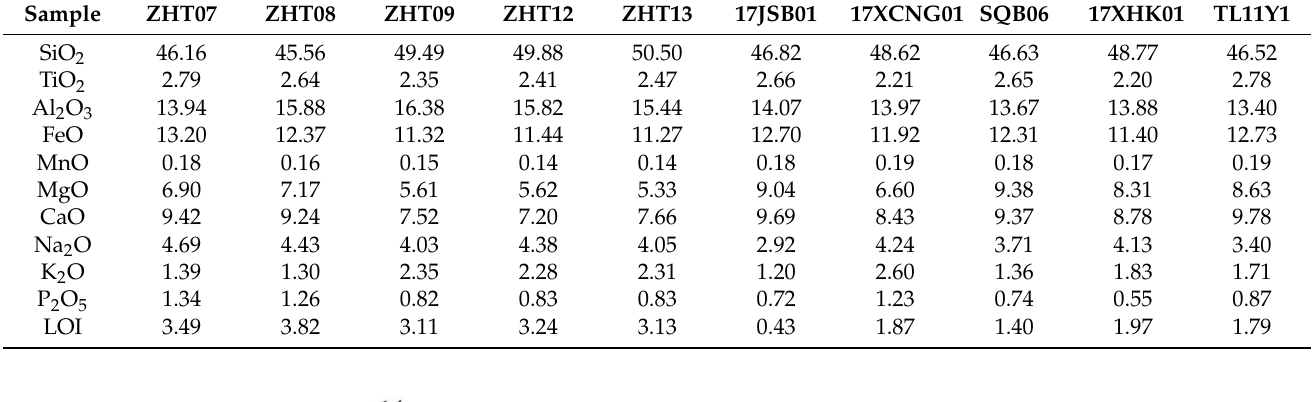
Table 3. Whole-rock major element data for the Hannuoba alkaline basalt (wt%).